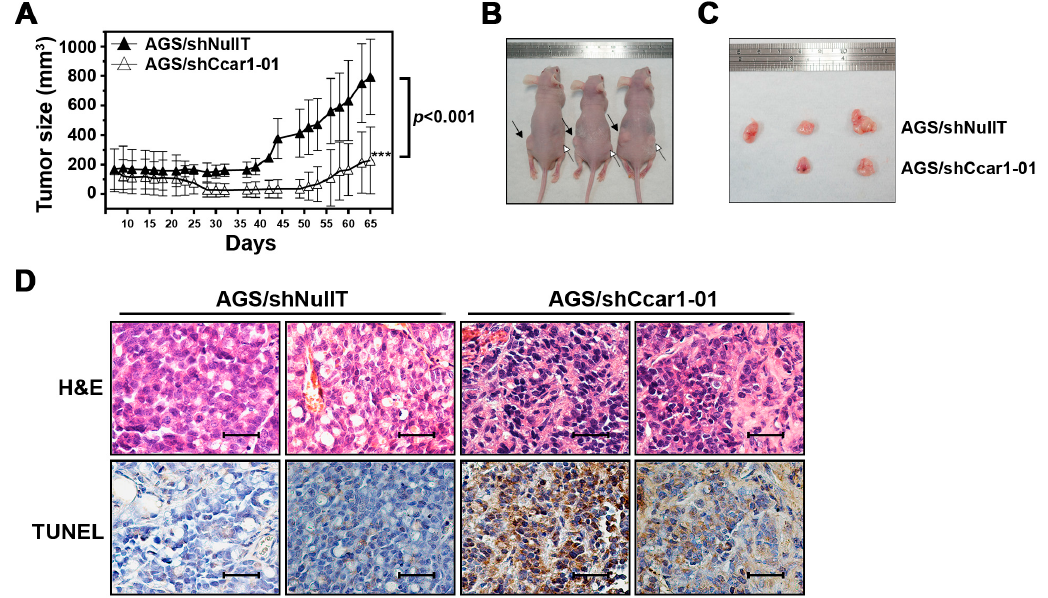
Figure 4. Effects of CCAR1 knockdown on xenograft gastric cancer formation. ( A ) Control or -shCCAR1-expressing AGS cells were injected subcutaneously into athymic nude mice to establish tumors. Tumor sizes were measured and depicted as tumor volume, and tumor growth curves were plotted accordingly. The symbol *** indicates p < 0.001; ( B ) Representative images showing subcutaneously injected xenograft tumors in nude mice at day 65 post subcutaneous injection. Black arrows indicate xenograft tumors derived from Control AGS cells, and white arrows indicate xenograft tumors derived from CCAR1 shRNA-expressing AGS cells; ( C ) Representative images showing respective xenograft tumors at day 65 post subcutaneous injection ( n = 3 per group). Data are presented as the mean with error bars representing the S.D; ( D ) Representative images of H&E and terminal deoxynecleotidyl transferase-mediated dUTP nick-end-labeling (TUNEL) staining (brown) of xenografts. Scale bar: 40 µm.